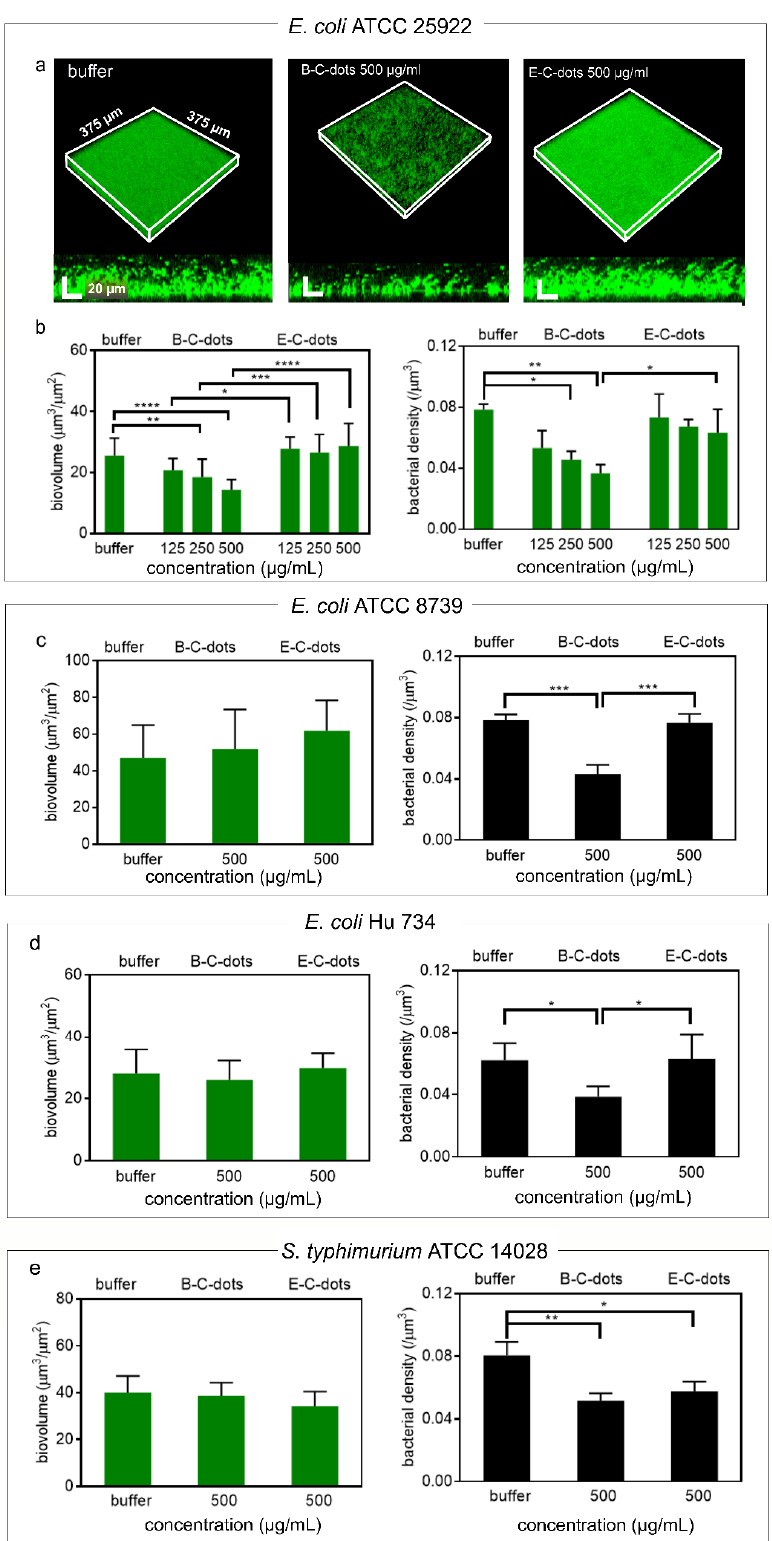
Figure 4. Effects of C-dots hydrothermally derived from B. breve ATCC 15700 (B-C-dots) and E. coli ATCC 25922 (E-C-dots) on 24 h grown infectious biofilms. ( a ) CLSM images of E. coli ATCC 25922 biofilms stained with green-fluorescent SYTO9 and red-fluorescent propidium iodide after 4 h exposure to 10 mM phosphate buffer (pH 7.4), and suspensions of B-C-dots or E-C-dots (500 µ g/mL) in phosphate buffer. ( b ) Biovolumes and volumetric bacterial densities of E. coli ATCC 25922